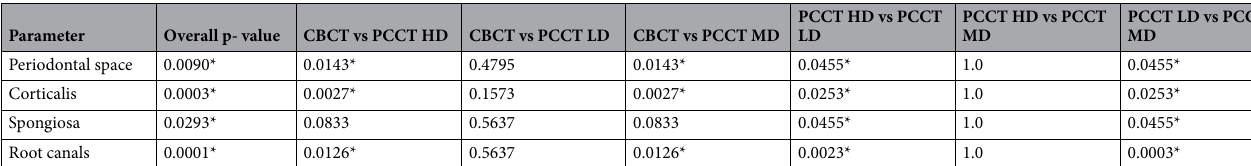
Table 2. Friedman Test and corresponding p-values. The asterisk (*) marks significant differences (p < 0.05).